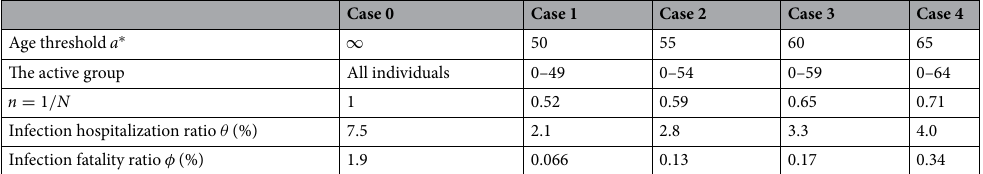
Table 1. Infection hospitalization ratio and infection fatality ratio for the active group with different a ∗ under the Japanese population composition. The age-specific severity ratios are adopted from 9 , whereas the Japanese population data from 16 . Case 0 (no protection measure) is shown for reference.